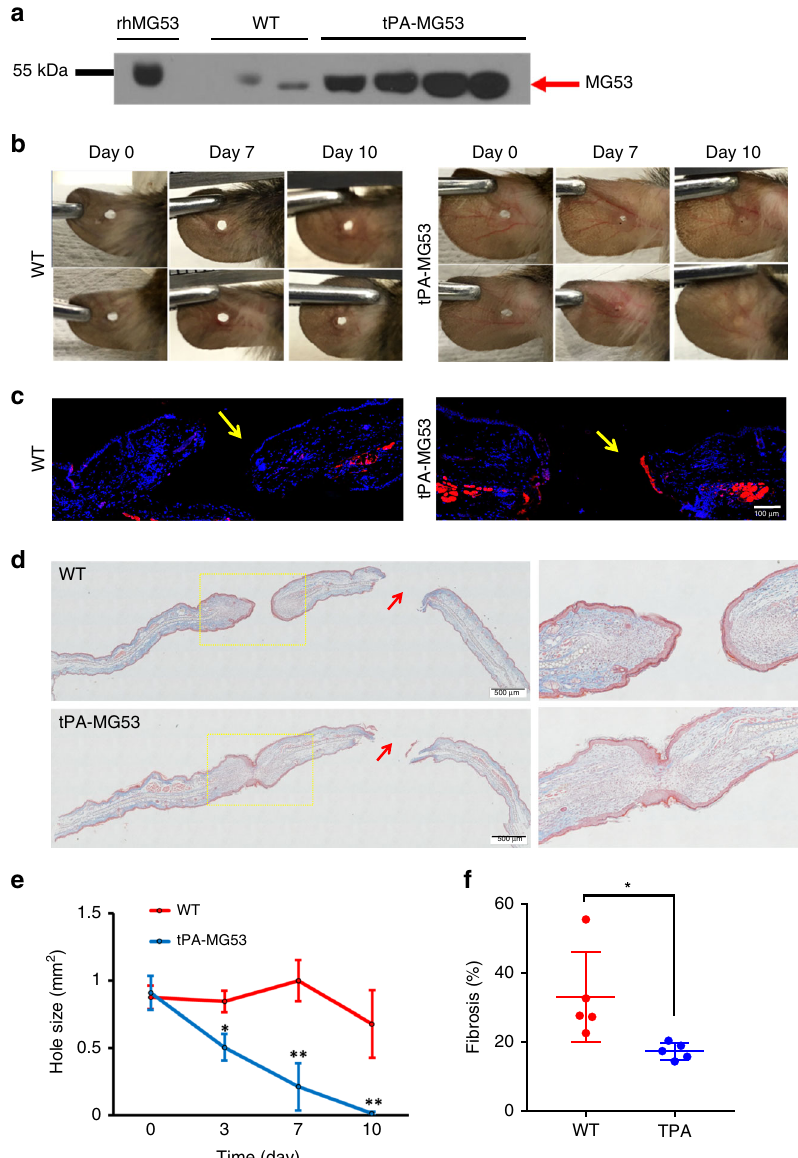
Fig. 3 tPA-MG53 mice show increased healing capacity following ear-punch injury. a tPA-MG53 mice in a mixed genetic background of 129/Sv and C57BL/6J expressed elevated levels of circulating MG53 compared with WT littermates. 1.3 µ l sera were loaded per lane and probed with anti-MG53 antibody. 0.1 ng of rhMG53 dissolved in serum derived from mg53 − / − mice was used as reference standard. b Representative pictures of ear punch injury in WT (left panels) and tPA-MG53 mice (right panels) at different days post-injury. c IHC revealed the concentration of MG53 at the leading edge of ear- punch at 2 h after wounding in the tPA-MG53 mice. d Masson ’ s trichrome staining showed remarkable differences in the ear skin architecture between WT and tPA-MG53 mice, with wounds created acutely at 2 h (red arrow) and 14 days (yellow rectangle) following ear punch. e WT mice do not heal over the 10-day observation, the tPA-MG53 mice all healed completely at day 10. n = 10 per group. f Areas positive for trichrome staining were used as index for tissue fi brosis. Quanti fi cation revealed signi fi cant difference between WT and tPA-MG53 mice at 14 days post ear-punch injury. * p < 0.05; ** p < 0.01. Error bar represents the standard deviation and p value was generated by t